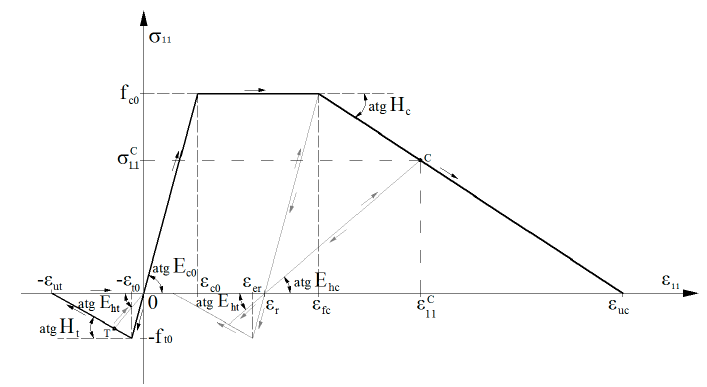
Figure 2. Concrete model.